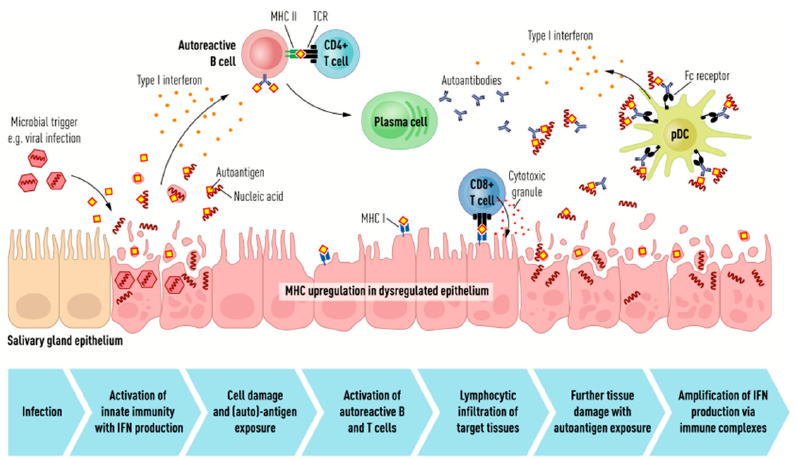
Figure 1. Schematic representation of the pathogenetic mechanisms at the basis of Sjogren syndrome. IFN : interferon. pDCs: plasmacytoid dendritic cells. MHC : major histocompatibility complex. TCR: T cell receptor. Reprinted with permission from Environmental factors in the pathogenesis of primary Sjögren’s syndrome, A. Björk, J. Mofors, M. Wahren-Herlenius., 2020, Journal of Internal Medicine, 287; 475–492.